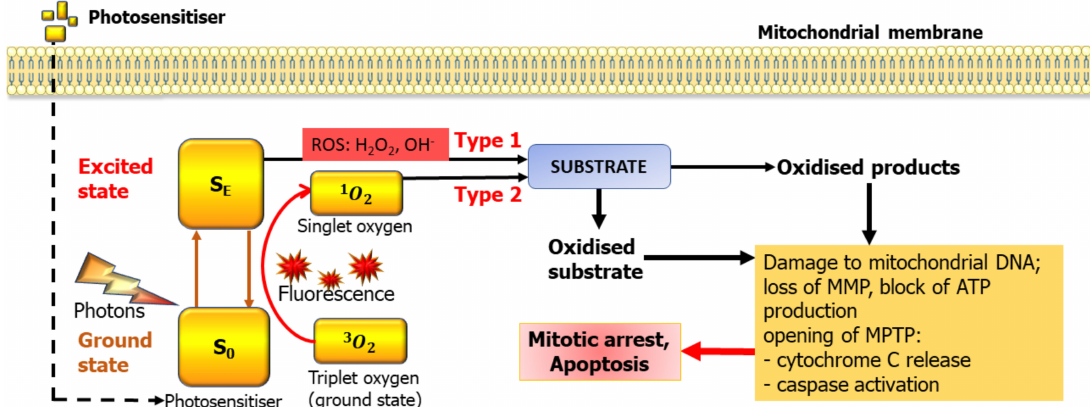
Figure 1. Basic mechanisms of photodynamic therapy (PDT) and its potential targets in mitochondria. MMP—Mitochondrial membrane potential, MPTP—mitochondrial transition